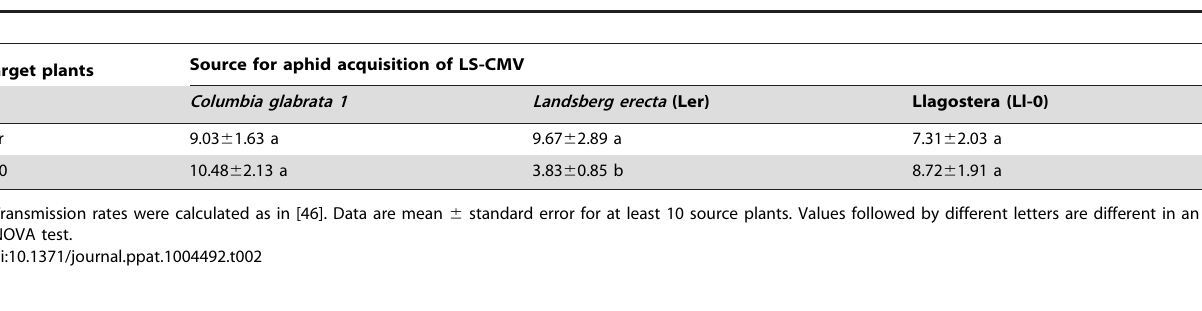
Table 2. Transmission rates of CMV-LS by a single Myzus persicae from three infected Arabidopsis genotype sources to Ler or Ll-0 1) .